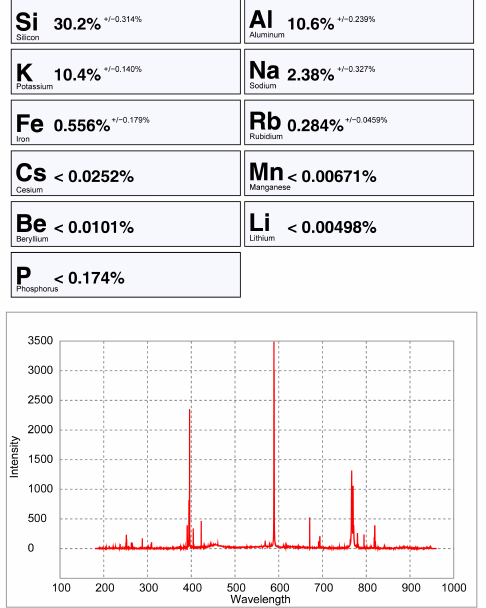
Figure 24. pLIBS analysis of a potassium feldspar with the Spd_Barroso